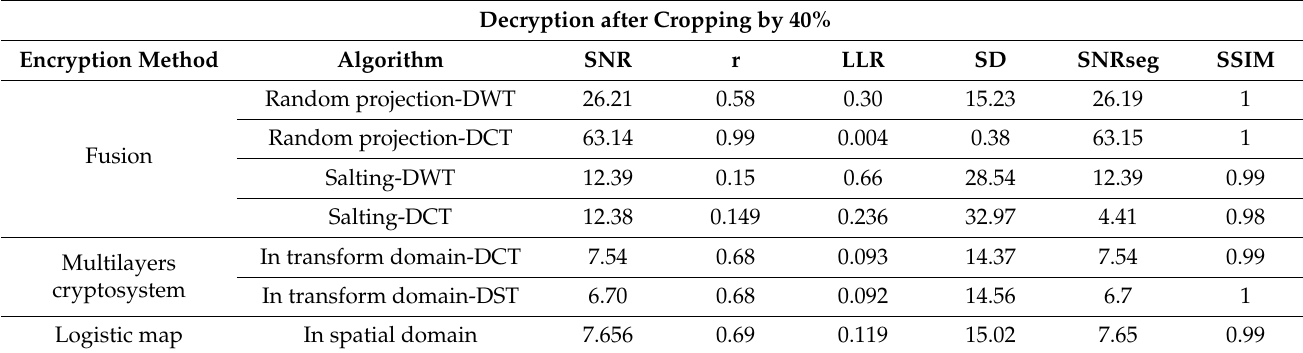
Table 5. Comparison of different decrypted signals after applying cropping. Decryption after Cropping by 40%